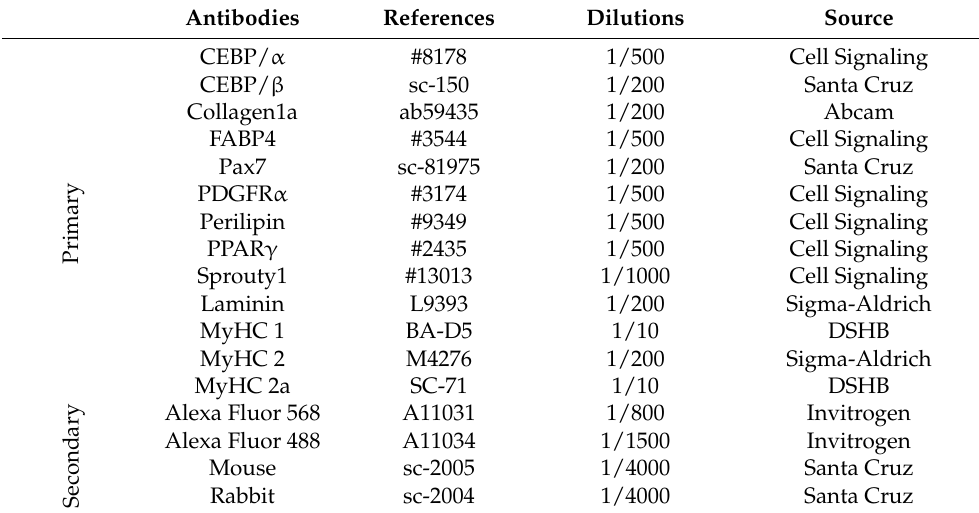
Table 1. Western Blot/Immunostaining